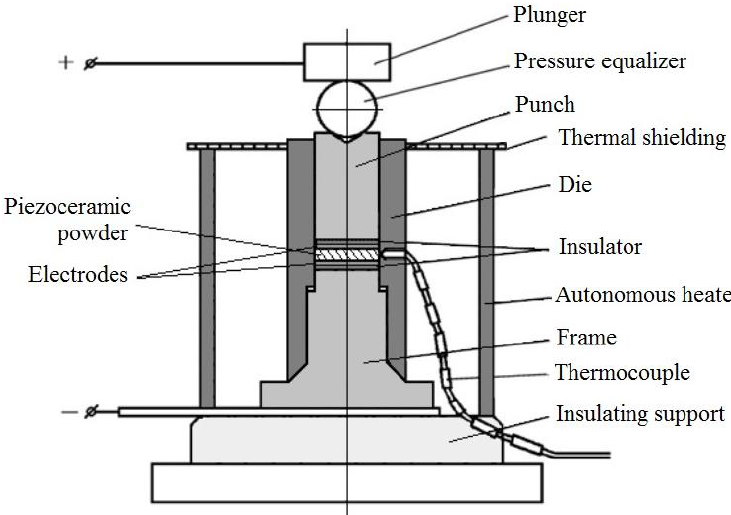
Figure 25. A set-up for pressing, sintering and polarization of piezoceramic